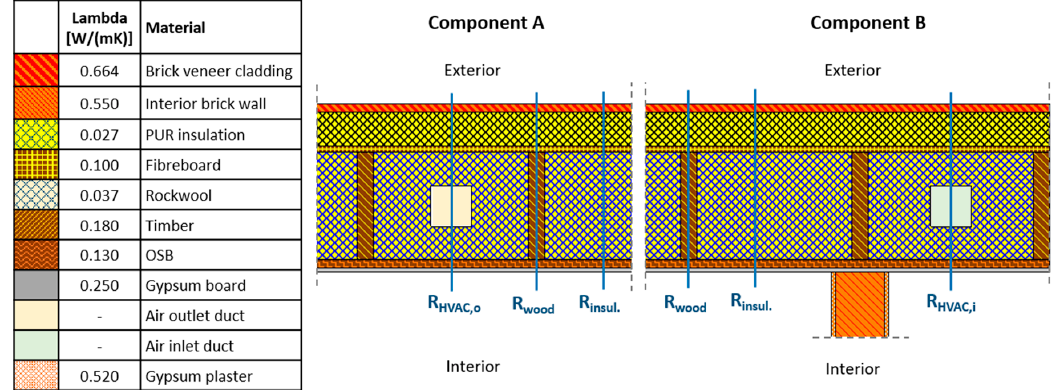
Figure 2. Horizontal section of the post-retrofit rear facade, component A and B.